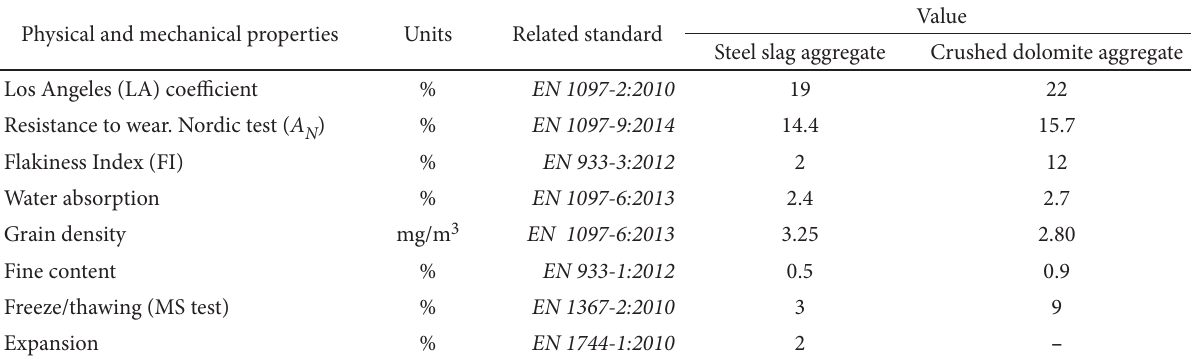
table 3. Physical and mechanical characteristics of steel slag aggregate Physical and mechanical properties